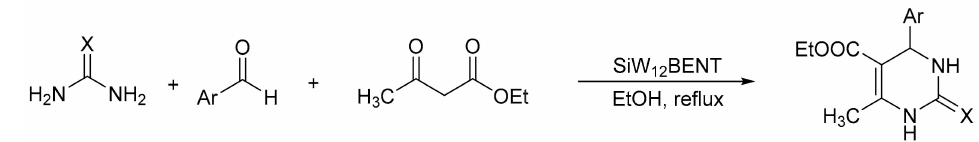
Scheme 1. General procedure for Biginelli derivative